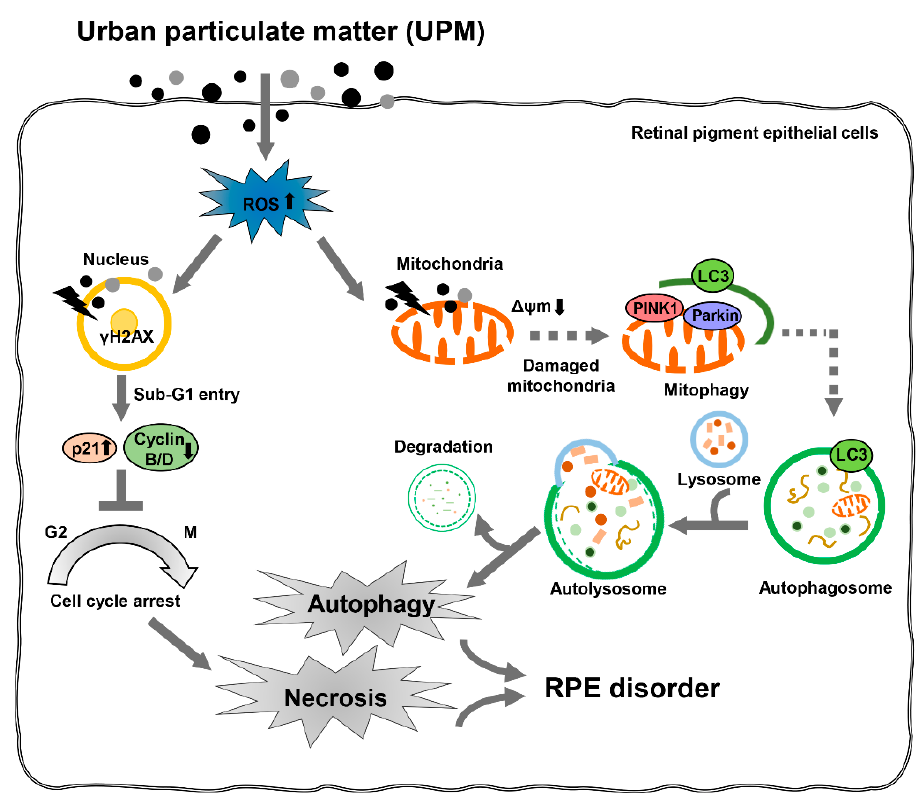
Figure 7. UPM promotes necrosis and autophagy via ROS-mediated cellular disorders that are ac- companied by cell cycle arrest and mitophagy in ARPE-19 cells. UPM induces cytotoxicity, which is